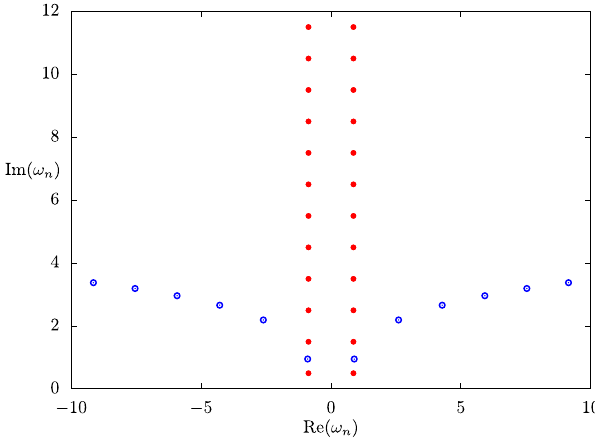
FIG. 9. QNM spectral instability of Pöschl-Teller potential. Combination of Figs. 3, 5, and 7, corresponding to three independent calculations, respectively: condition number ratios κ = κ 0 (top panel), pseudospectrum, and perturbed QNM spectra n (bottom panel). The bottom panel demonstrates the high-fre- quency nature of the spectral instability, as well as the migration of Pöschl-Teller QNMs towards pseudospectrum contour lines under high-frequency